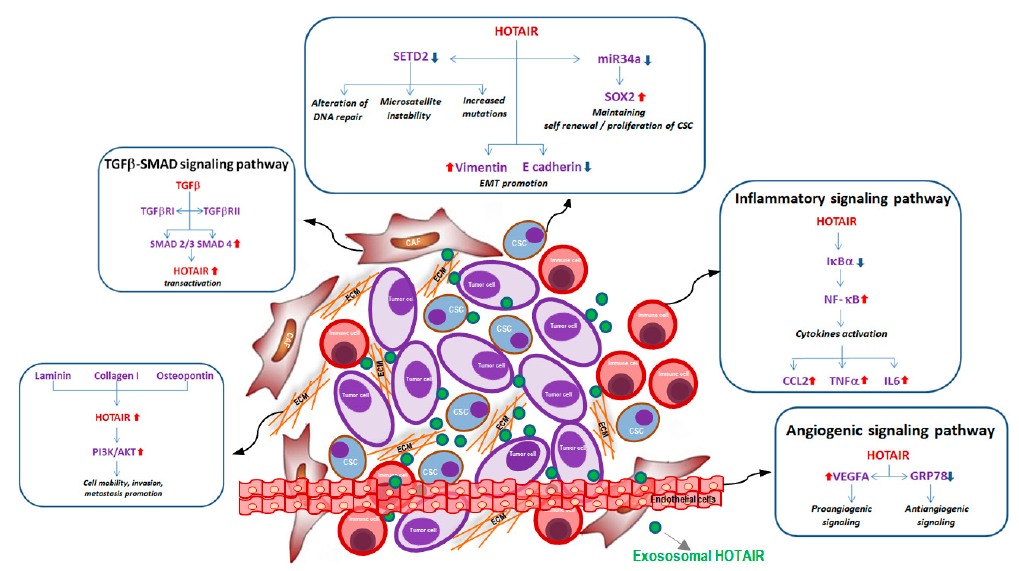
Figure 2. Schematic representation of exosomal HOTAIR in tumor microenvironment with details of the main molecular pathways associated with cellular and non-cellular components: (i) In CAF cells: TGF- β assembling the receptor complex (TGFbRI-TGFbRII) activates Smad proteins (SMAD2, SMAD3 and SMAD4) that directly bind HOTAIR promoter, inducing its transactivation; (ii) In CSC cells: HOTAIR leads to (a) the downregulation of the tumor suppressor gene SETD2 , promoting microsatellite instability, high mutation rate, and interfering with DNA damage repair, (b) the downregulation of miR34 a with the consequent induction of stem cell marker Sox2 ; (iii) In endothelial cells: HOTAIR induces angiogenesis-promoting VEGFA transcription and downregulating the anti-angiogenetic marker GRP78 ; (iv) In immune cells: HOTAIR is able to induce the degradation of I κ B α with the consequent activation of NF- κ B pathways and secretion of pro-inflammatory cytokines; (v) ECM proteins: Laminin, Collagen I, Osteopontin are able to induce HOTAIR overexpression modulating PI3K / AKT pathways and promoting cell mobility and